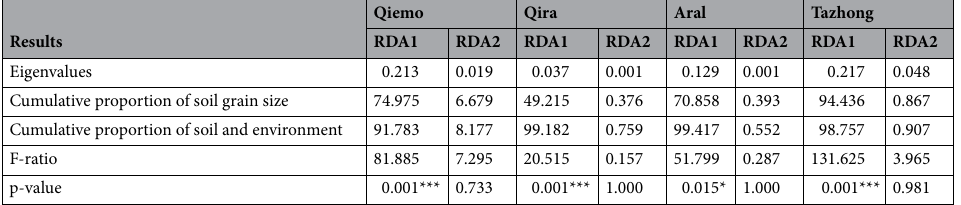
Table 3. db-RDA of the relationship between soil GSD and environmental factors. * p < 0.05, *** p < 0.001.